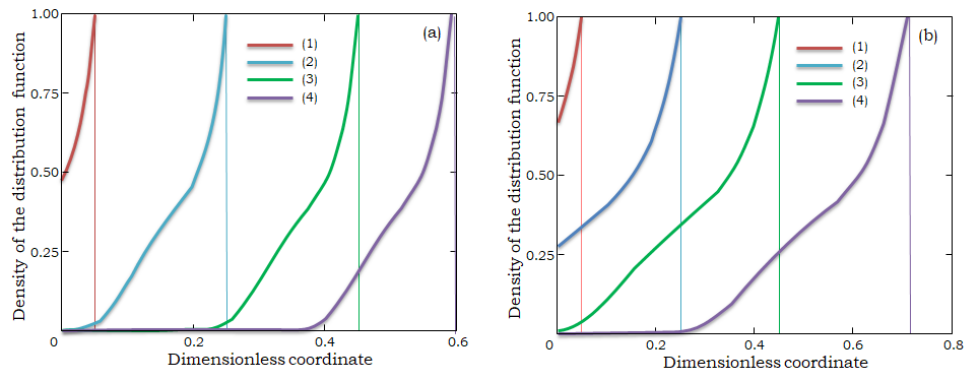
at different times l 0